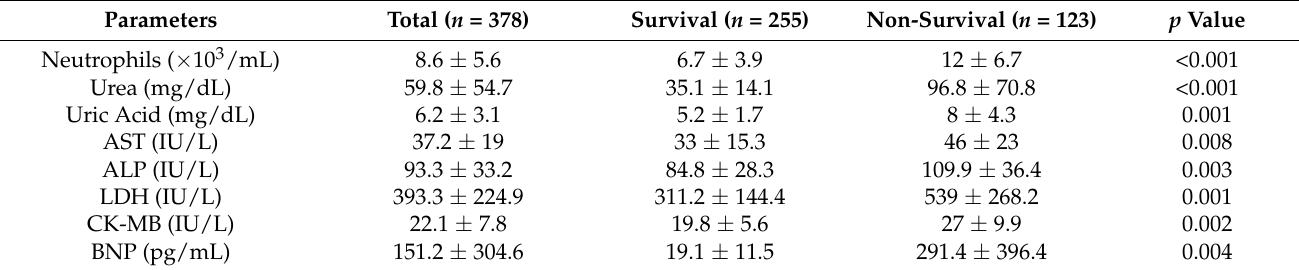
Table 2. Laboratory parameters of patients enrolled in the study. Data are expressed as media ± standard deviation. Differences were considered significant when p < 0.05. We only show laboratory parameters that significantly differed between groups. AST, aspartate aminotransferase; ALP, alkaline phosphatase; LDH, lactate dehydrogenase; CK-MB, creatinine kinase myocardial band; BNP, brain natriuretic